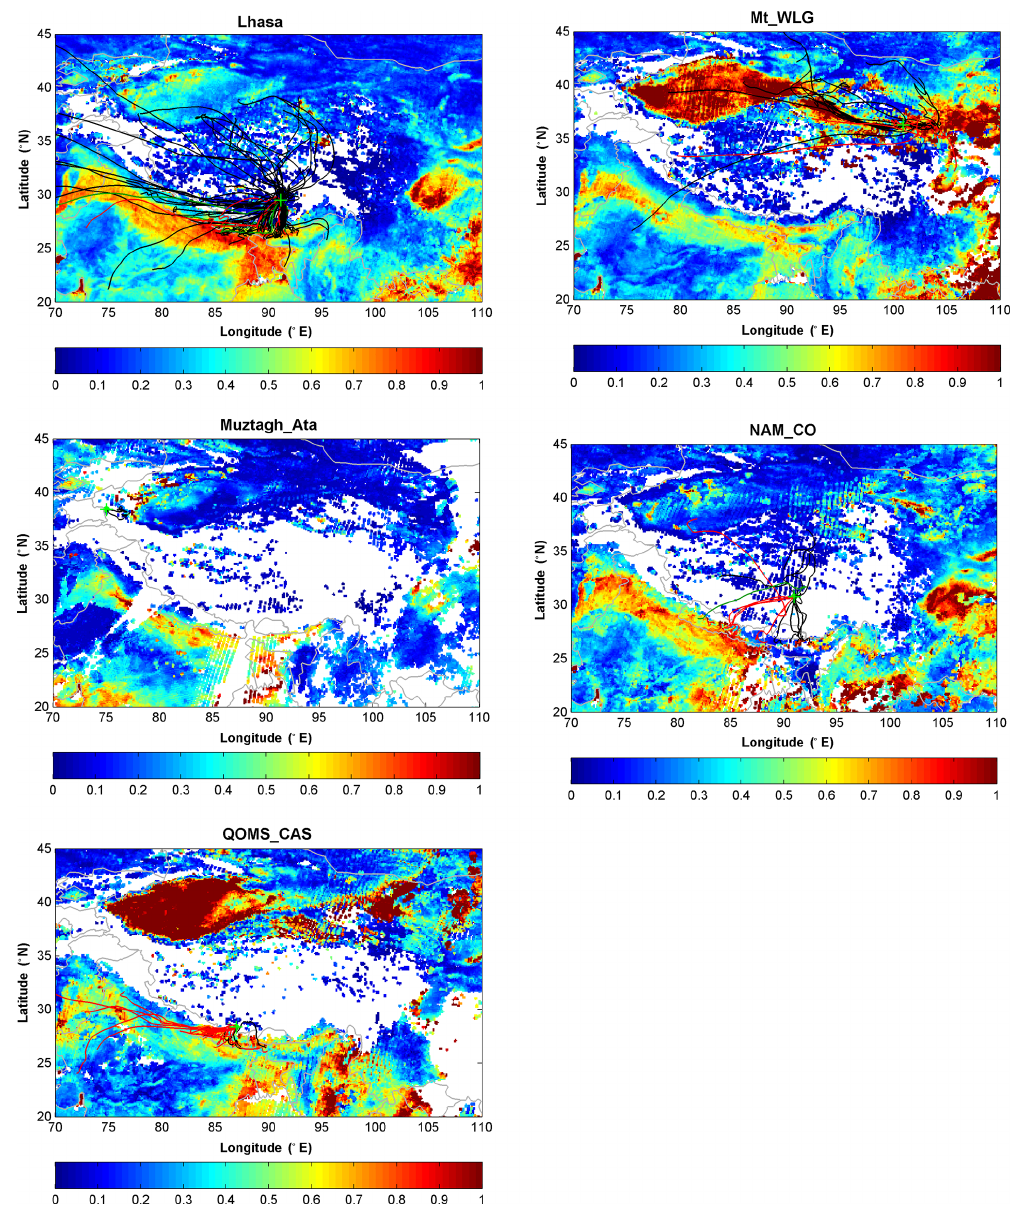
Figure 12. The back trajectories ending at the five sites (10ma.g.l.) on the Tibetan Plateau overlaid with the mean MODIS_AOD at 550nm on the high aerosol loading day observed by ground-based CE318 (CE318_AOD > 0.4). Red stands for EAE > 1.0, black for EAE < 0.5, and green for EAE within